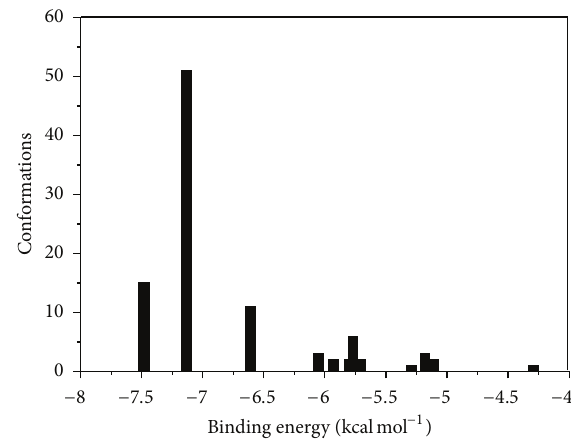
= 1.0 × 10 −4 mol L −1 ); (b) bonded BSA ( 𝐶 BSA